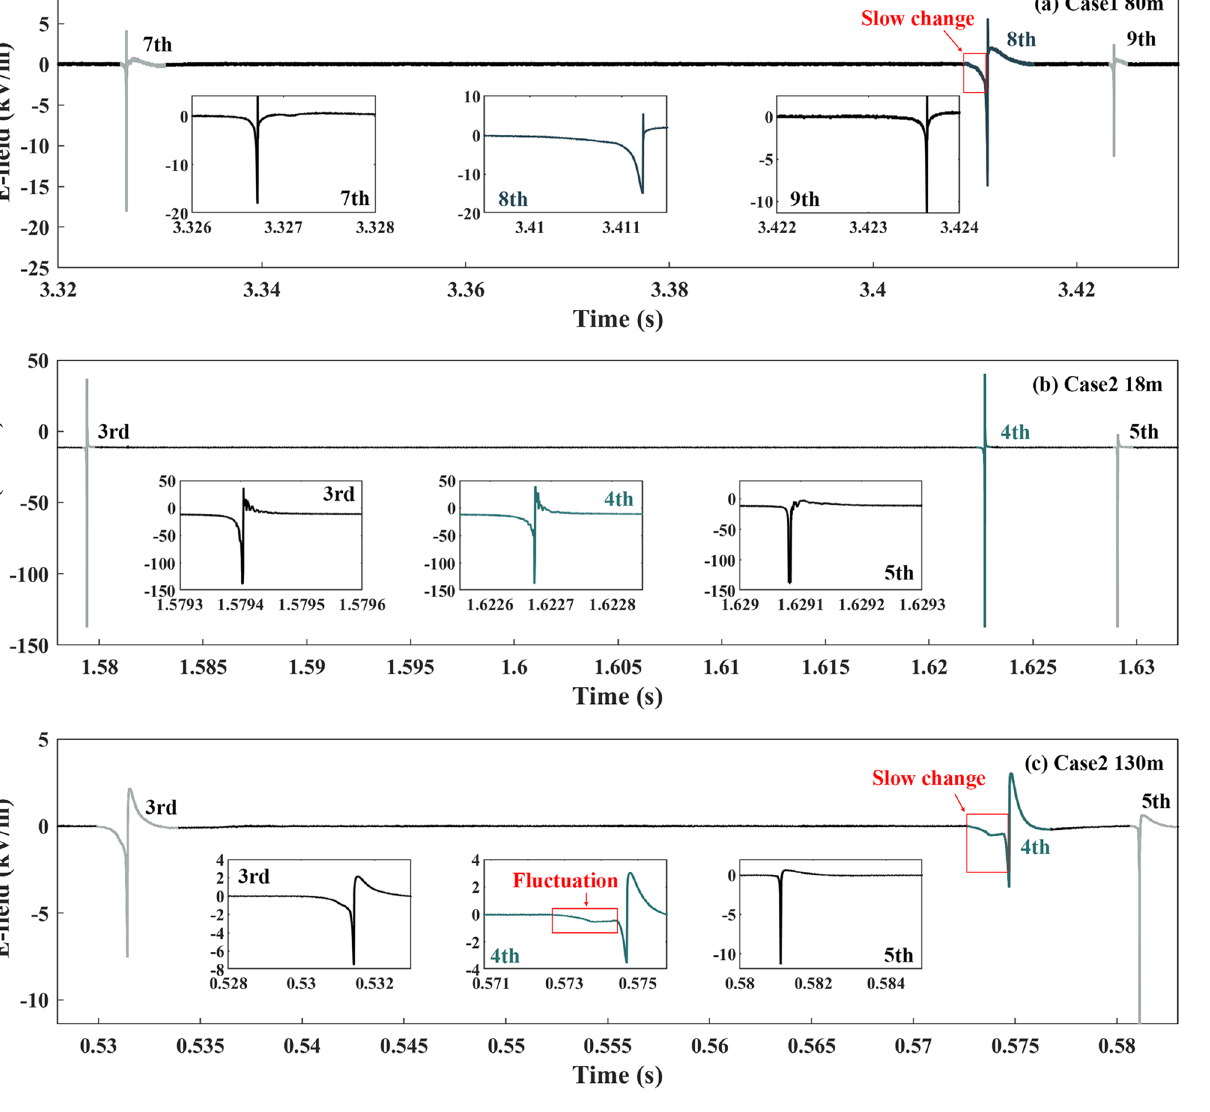
Figure 3. The E-field waveforms of Cases 1 and 2, along with their previous and subsequent downward leader– return stroke